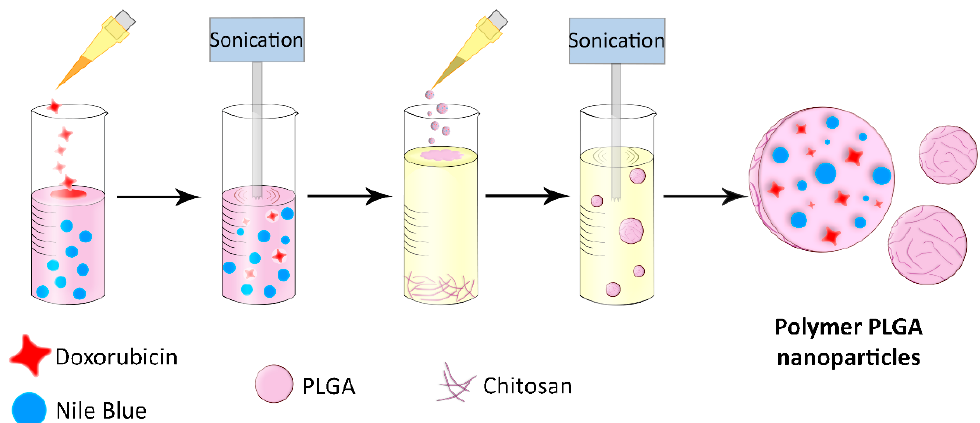
Figure 2. Schematic illustration of polymer nanoparticle synthesis via double emulsion method. The first emulsion was produced by sonication of doxorubicin water solution and solution of PLGA and Nile Blue in chloroform. The second emulsion was created by adding the first emulsion to the PVA and chitosan oligosaccharide lactate water solution. Next, the as-obtained suspension was centrifuged thrice and thus colloidally stable polymer PLGA nanoparticles were obtained.